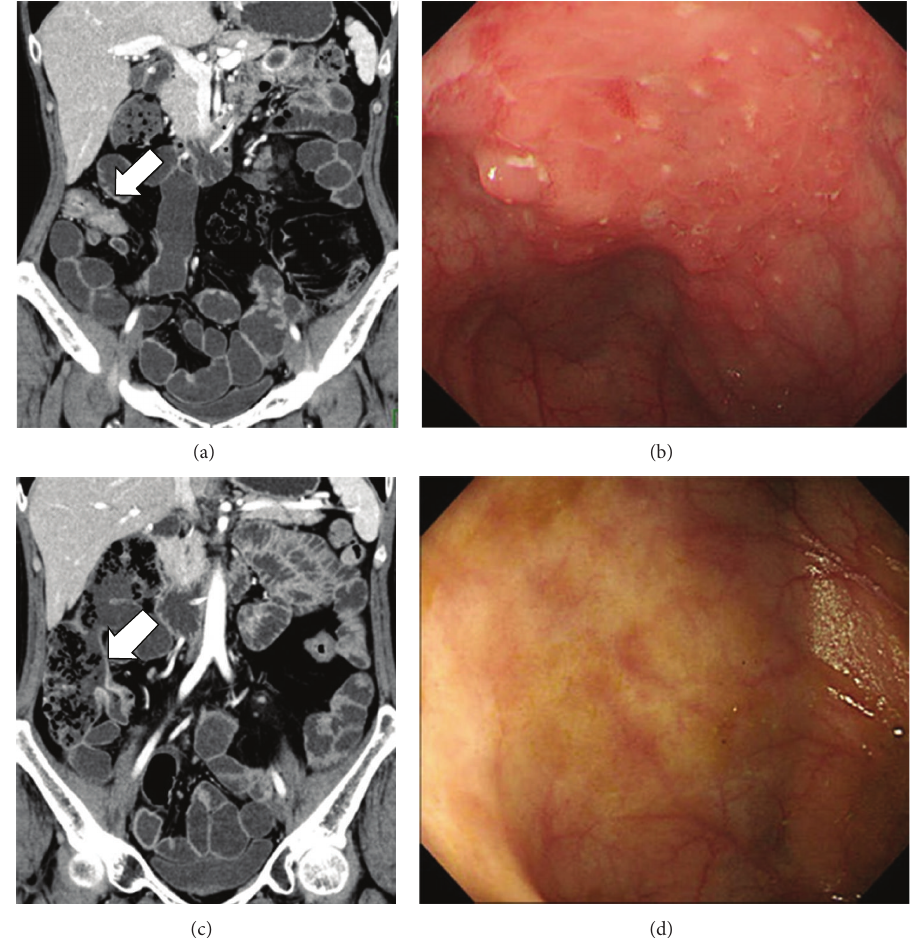
Figure 2: Findings from CT enteroclysis and endoscopic mucosal examination before and after the introduction of biologics. (a) CT enteroclysis before the introduction of biologics. (b) Mucosal findings corresponding to the same location as indicated by the arrow in (a) show edema. (c) CT enteroclysis at 84 days after the first CT enteroclysis showing improvement of the inflammation. (d) Mucosal findings corresponding to the same location as indicated by the arrow in (c) show no edema or